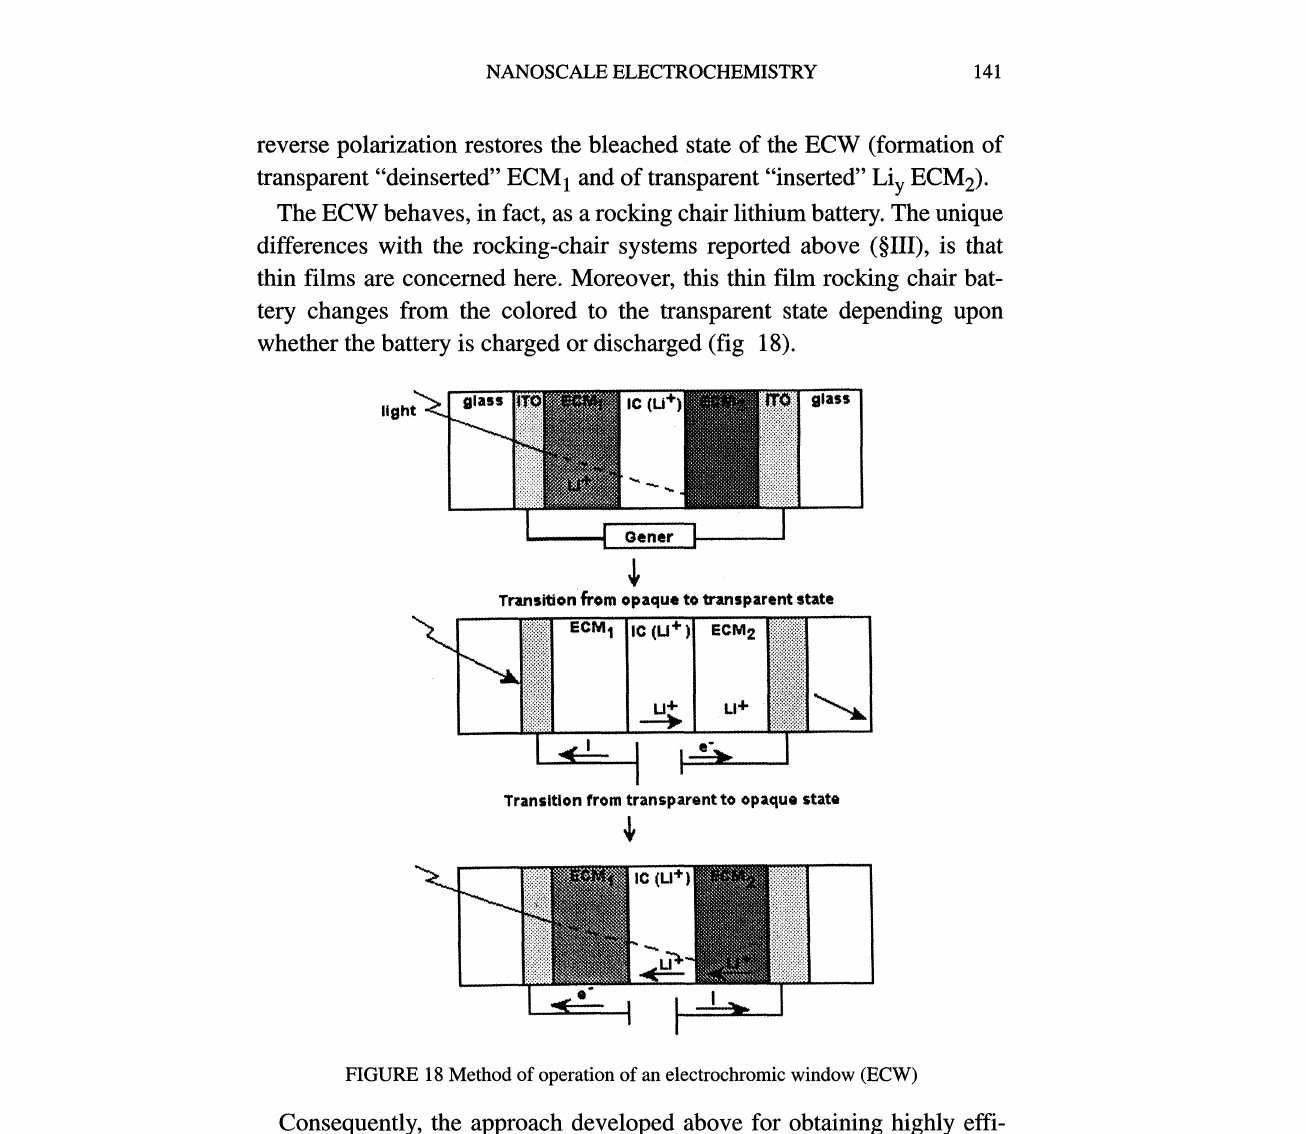
FIGURE 18 Method of operation of an electrochromic window